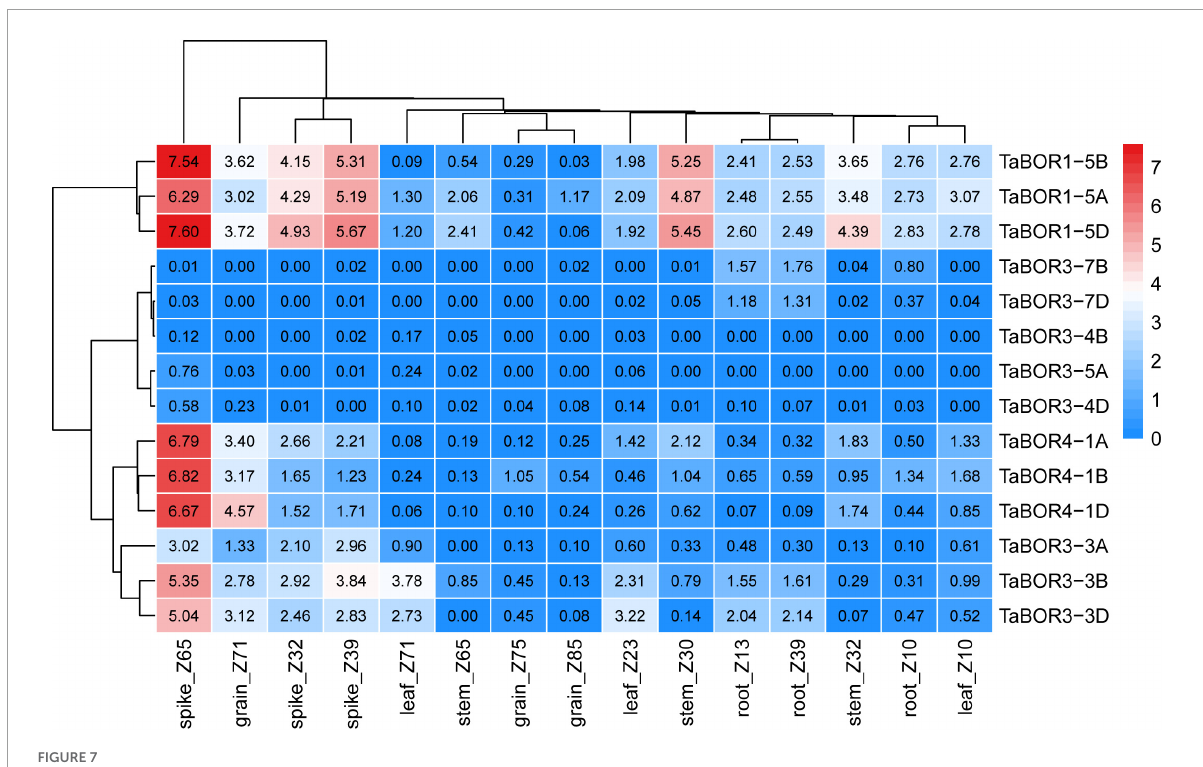
FIGURE7 Expression profiles of TaBOR genes in various